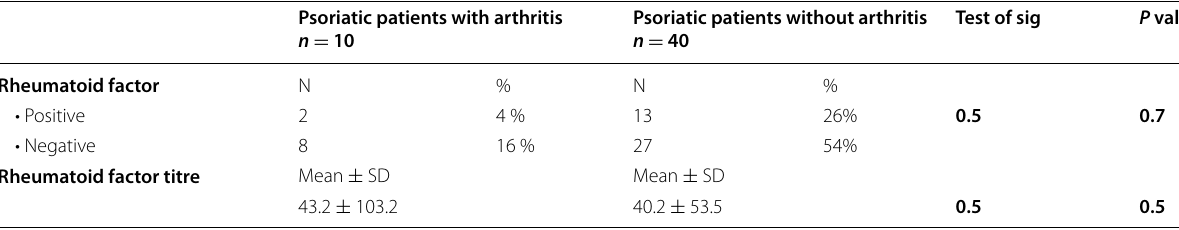
Table 5 Rheumatoid factor in psoriatic patients with and without arthritis